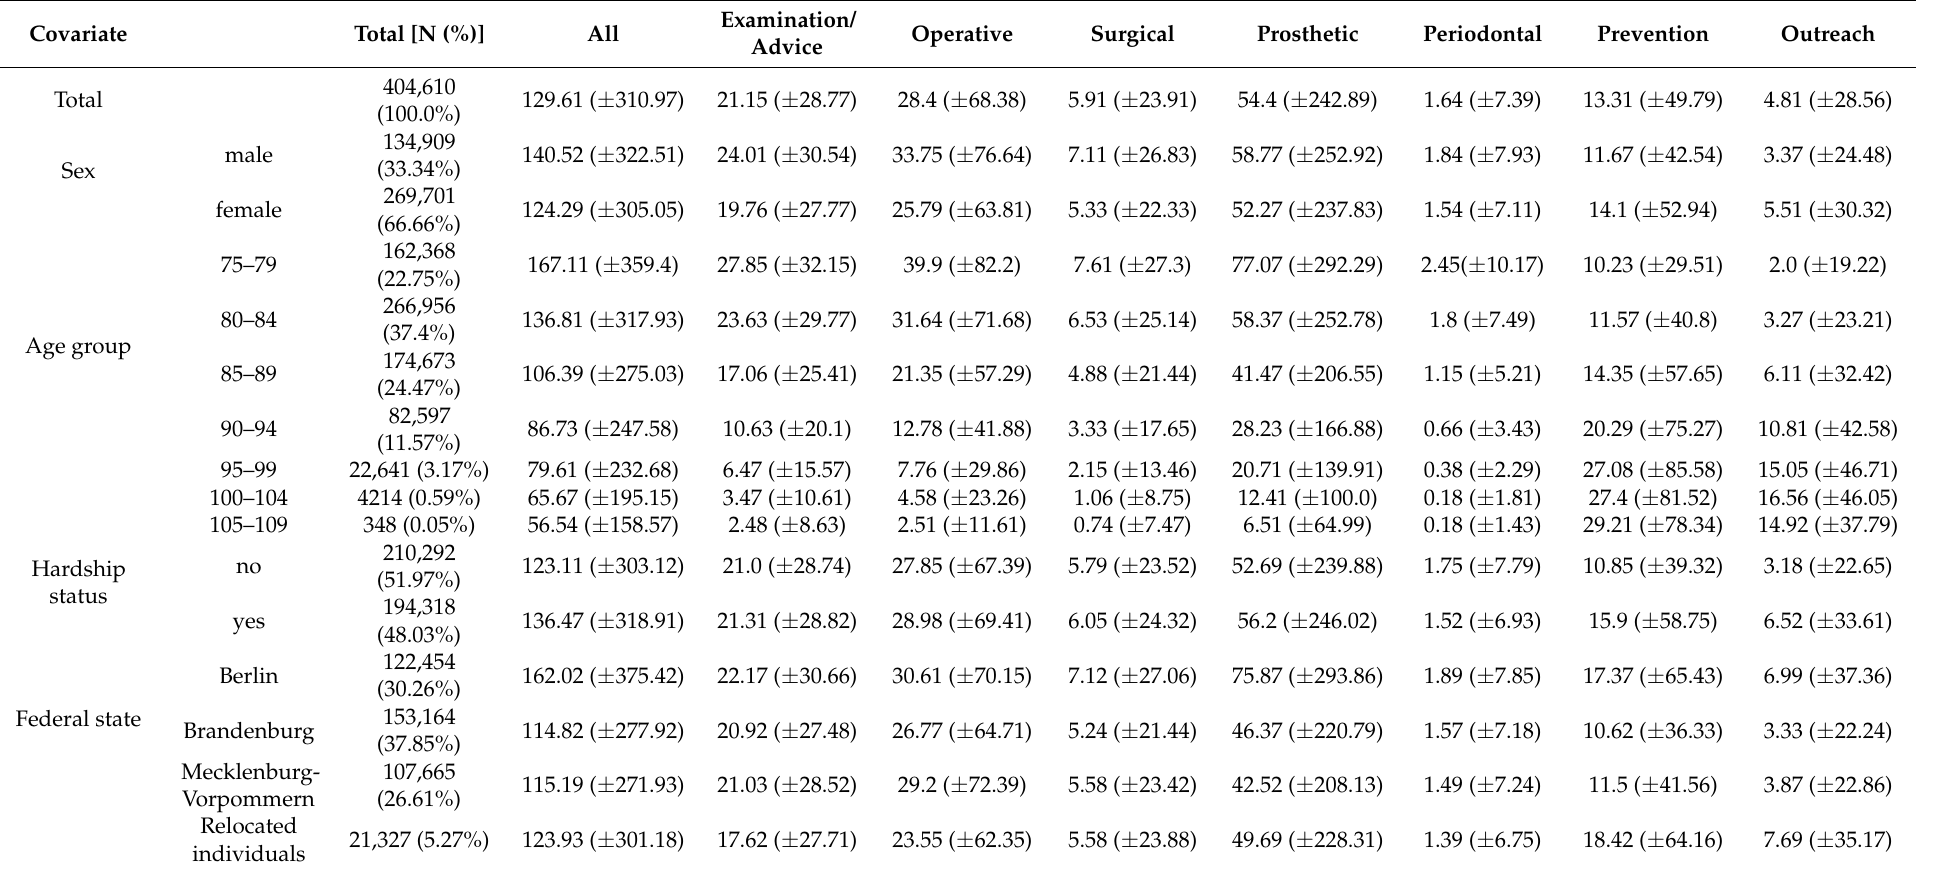
Table 1. Sample characteristics (N, %) and mean costs ( ± standard deviation (SD)) for dental services for the very old in Northeast Germany. Total, male and female population aged 75 years or older, in 5-years age bands, according to social hardship status and federal state are